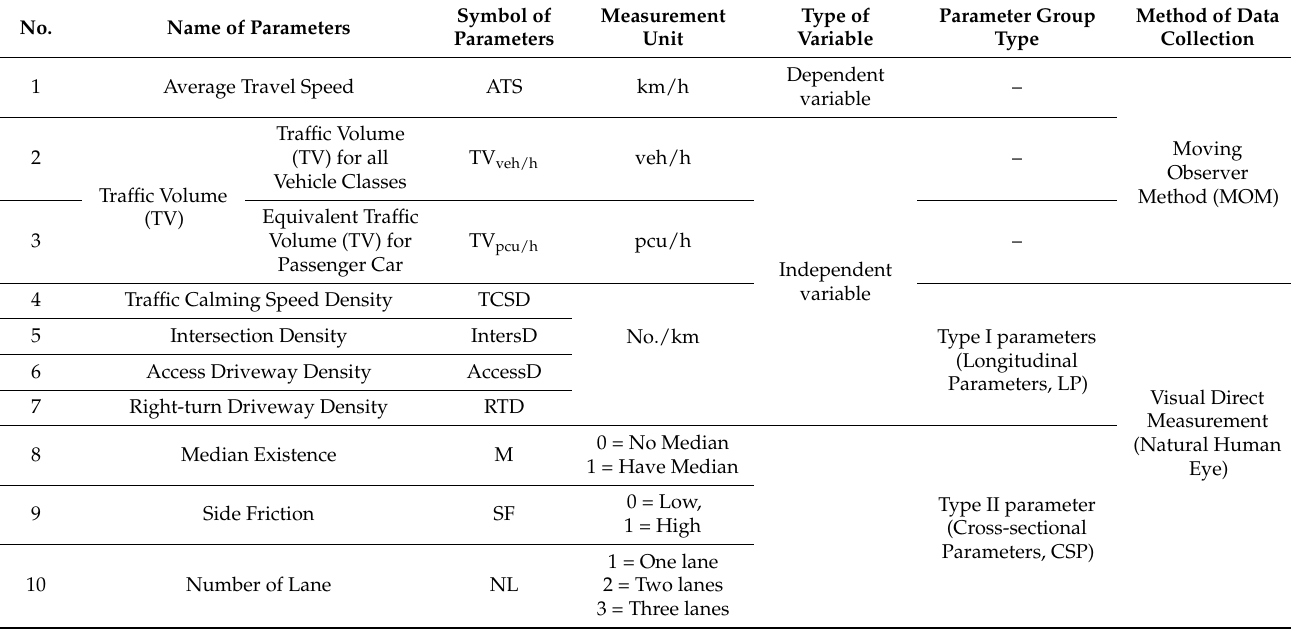
Table 2. Details of various parameters and collected data.